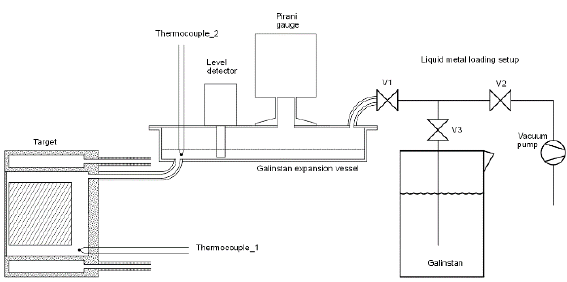
Fig. 7 Logic working scheme of the CoolGAL target system, including the setup to load it with Galinstan and provide the vacuum in the expansion